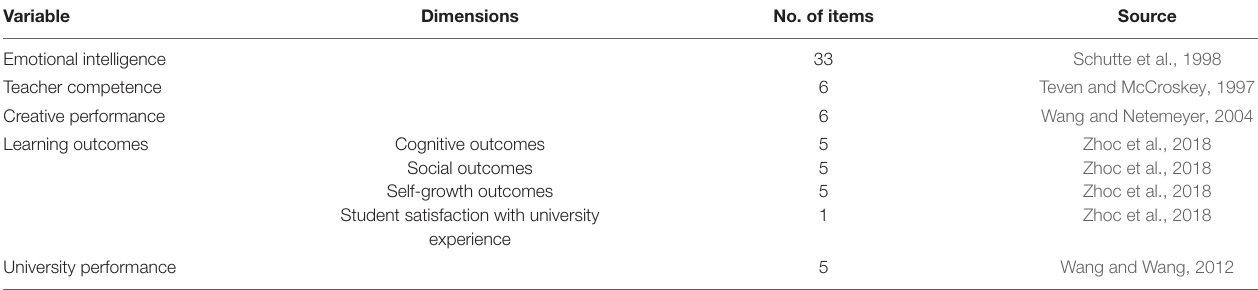
TABLE 2 | Source of measurement